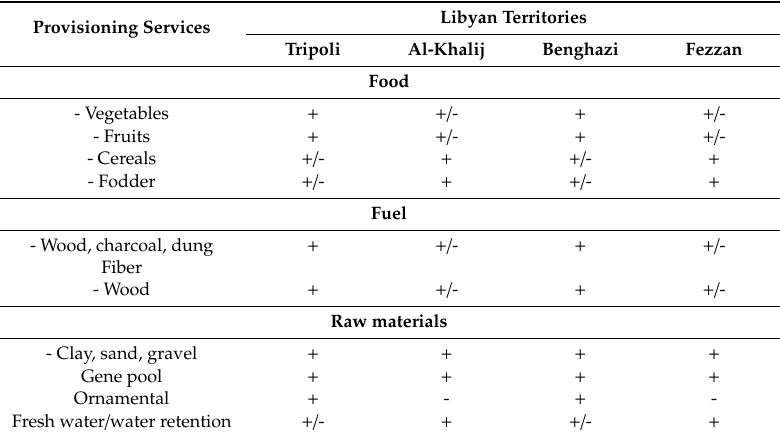
Table 7. Provisioning soil-based ecosystem services by territories.